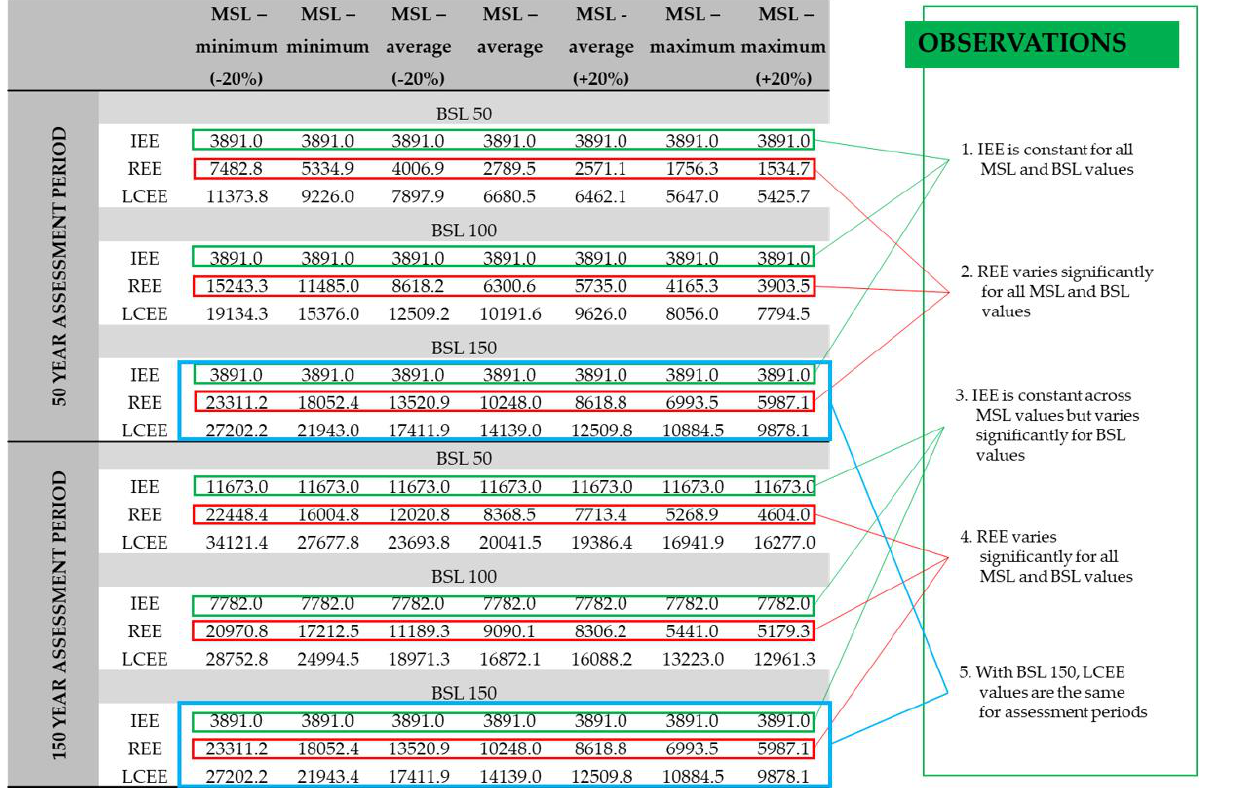
Figure 11. Annotated sensitivity analysis for MSL, BSL and assessment period data.